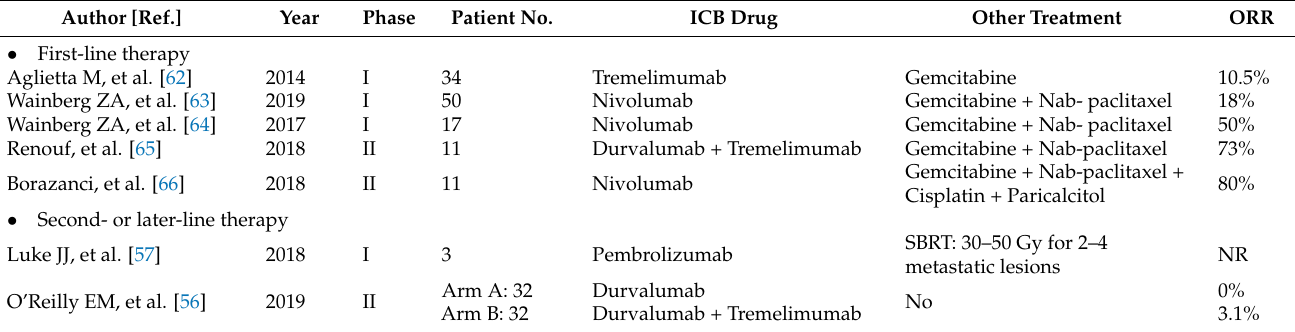
Table 2. The effectiveness of ICB therapy on